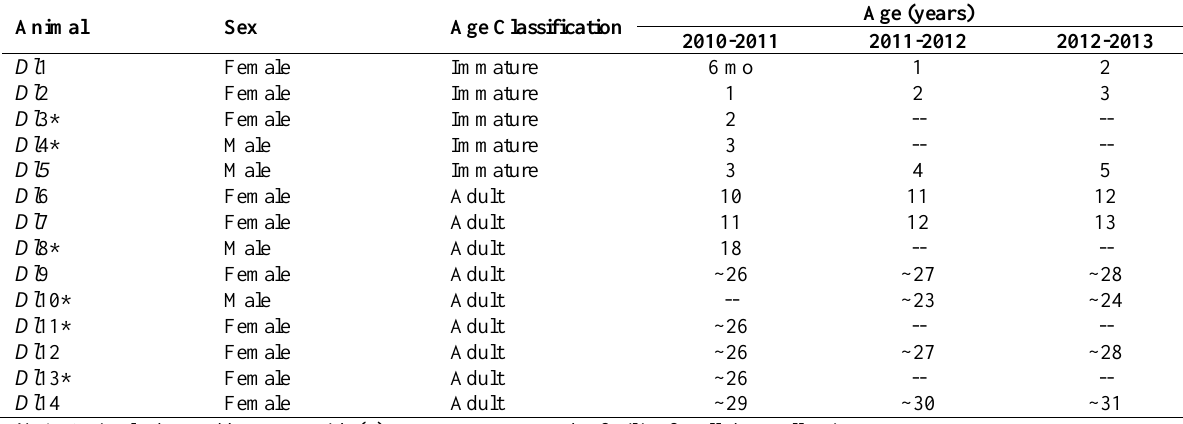
Demographics for Beluga